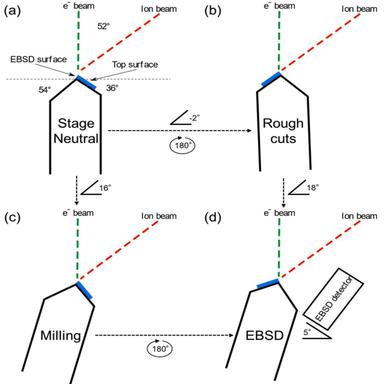
The sample geometry in each stage position for a 3D EBSD experiment with the necessary movements to switch between them (a) neutral, (b) rough cuts, (c) milling, and (d) EBSD.